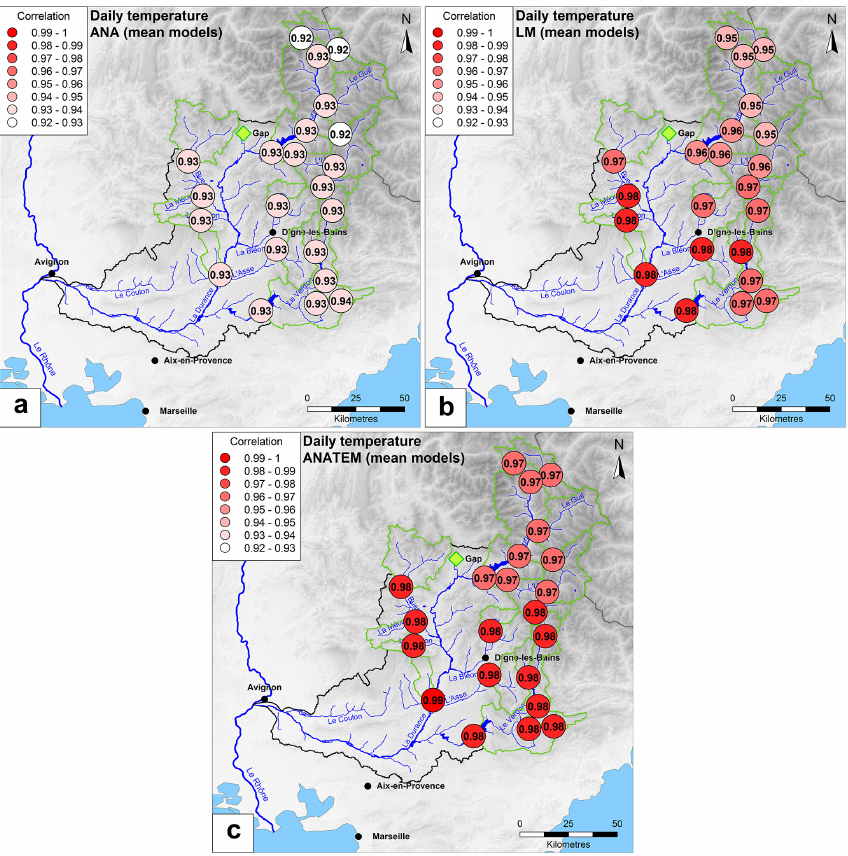
Figure 12. Regional correlation patterns of air temperature mean reconstructions by the (a) analogue model (ANA), (b) local model (LM) and (c) ANATEM model (daily time